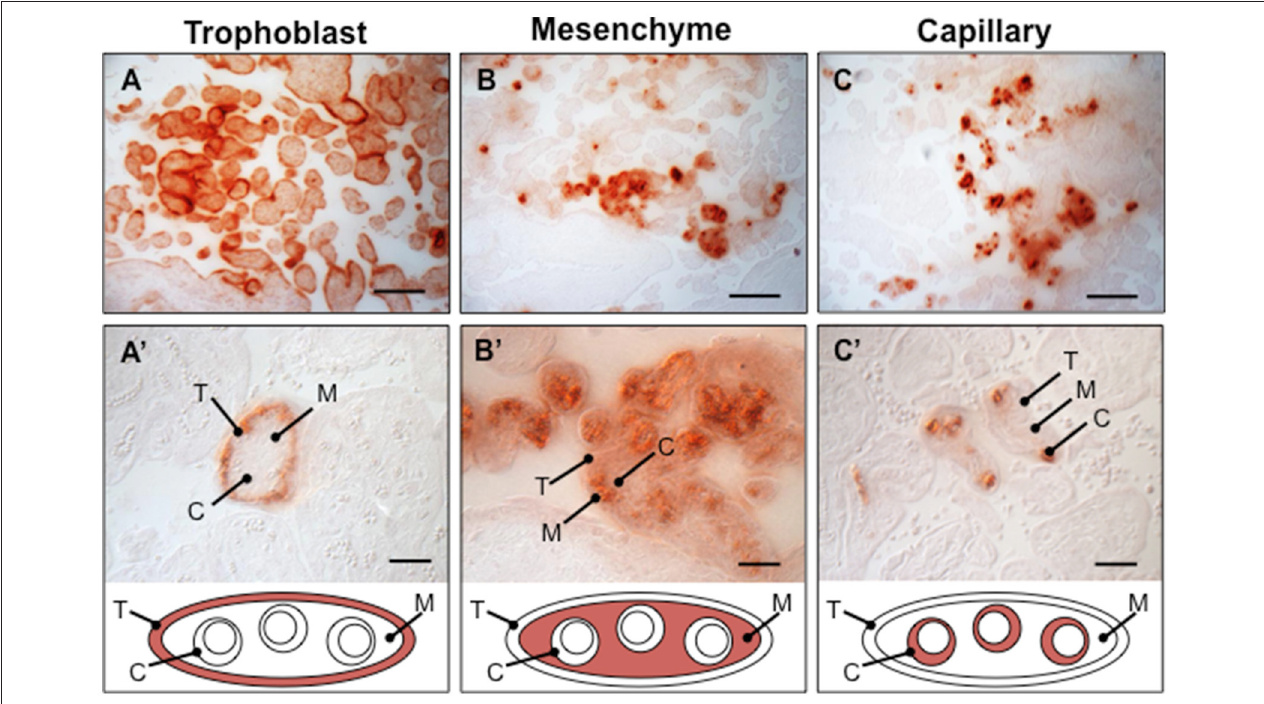
FIGURE 1 | Observed calcium pattems in human placenta villi. Placental biopsies between 28-33week gestation age were paraffin embedded, sectioned, and stained with Alizarin Red ( N = 16 placentae). Several distinct calcium deposition patterns varying in histoanatomical specificity were identified in chorionic villi, including trophoblast (A,A’) , mesenchyme (B,B’) , capillary (C,C’) , and mixed (not shown). T, trophoblast; M, mesenchyme; C, capillary. Scale bar in A–C : 100 µ m. Scale bar in D–F: 20 µ